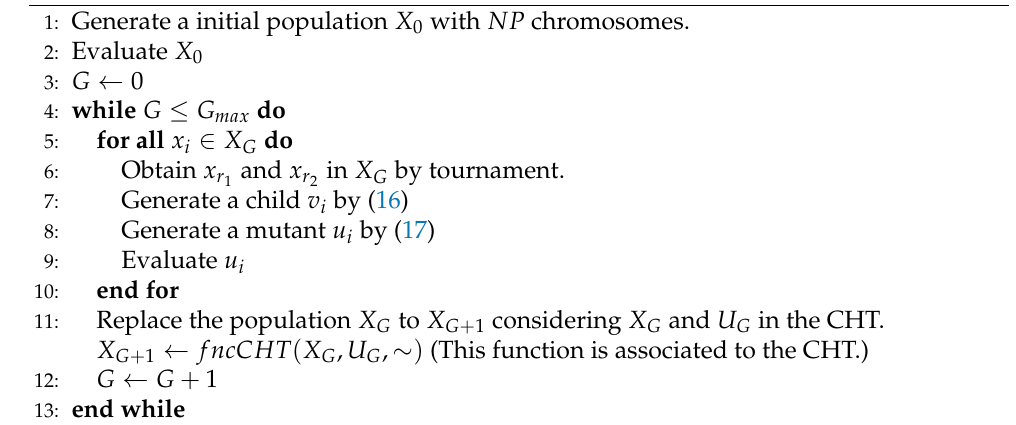
Algorithm 3 Genetic algorithm